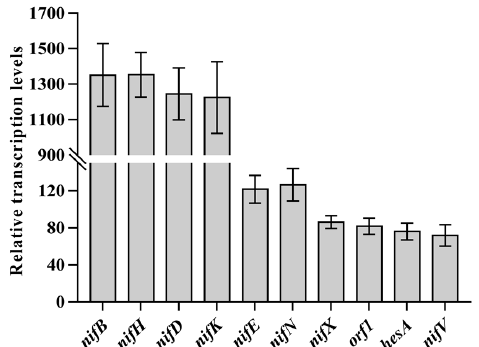
Figure 5. qRT-PCR analysis of transcripts of nifBHDKENXorf1hesAnifV genes of P. graminis RSA19 under N 2 -fixing conditions. All values indicate relative fold increase of transcription standardized against 16S rDNA transcript levels.